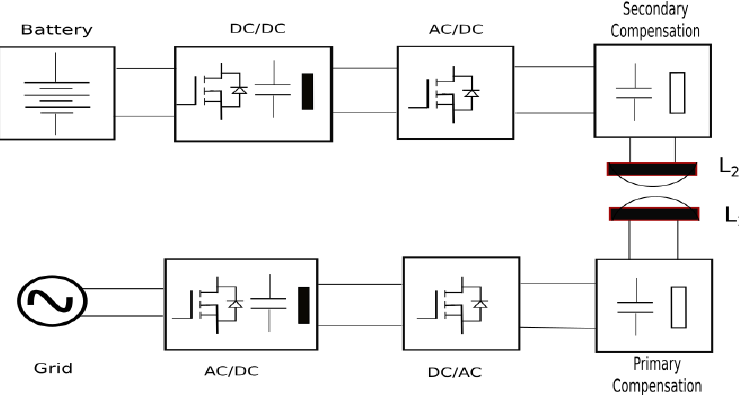
Figure 1. General wireless power transfer block diagram.